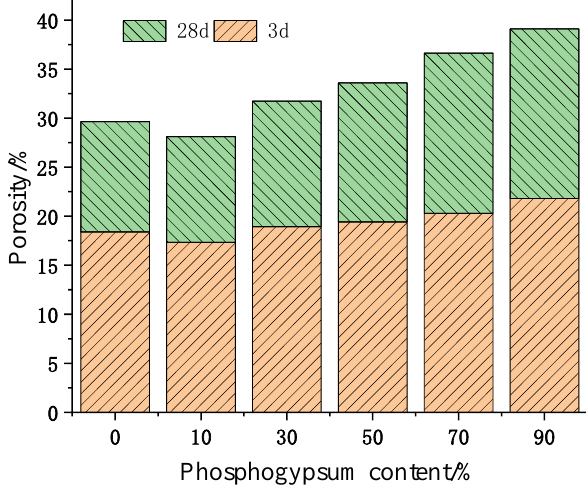
Figure 4. Porosity of composite cementitious material.